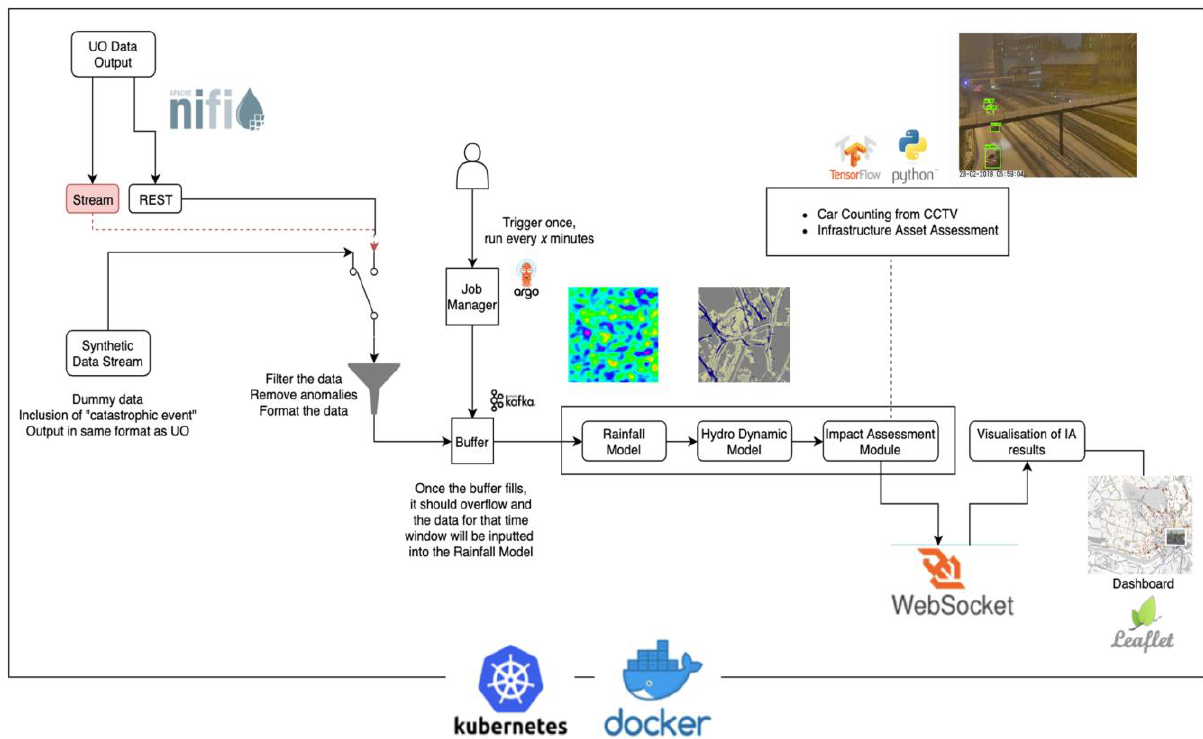
Figure 7. The prototype Flood-PREPARED workflow developed for a simulated extreme rainfall event of 53mm for the city of Newcastle upon Tyne